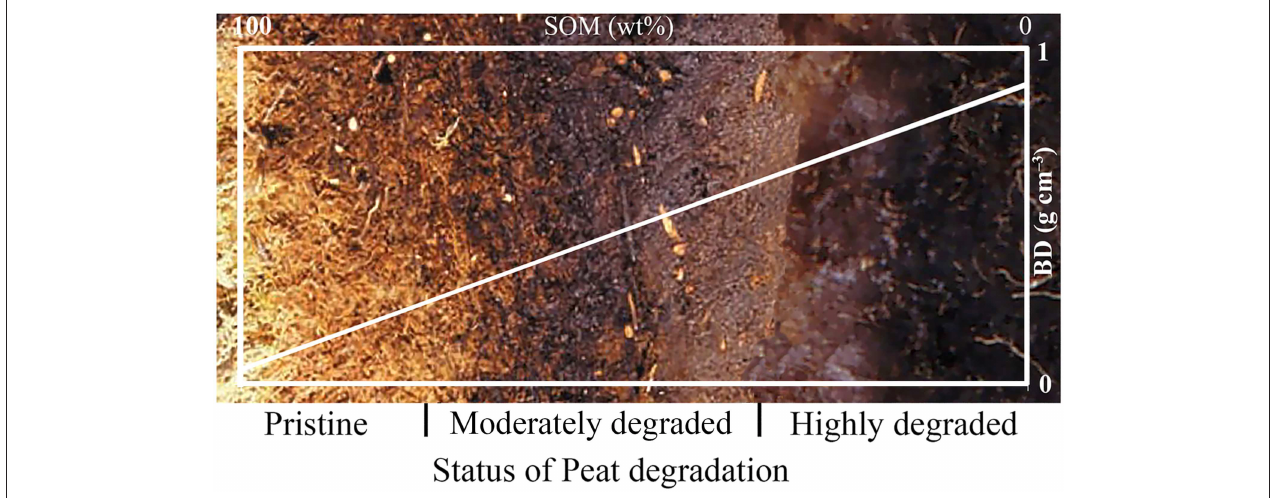
FIGURE 1 | Morphological structure of peat soils at various degradation stages (pristine, moderately degraded, and highly degraded). SOM, soil organic matter; BD, bulk